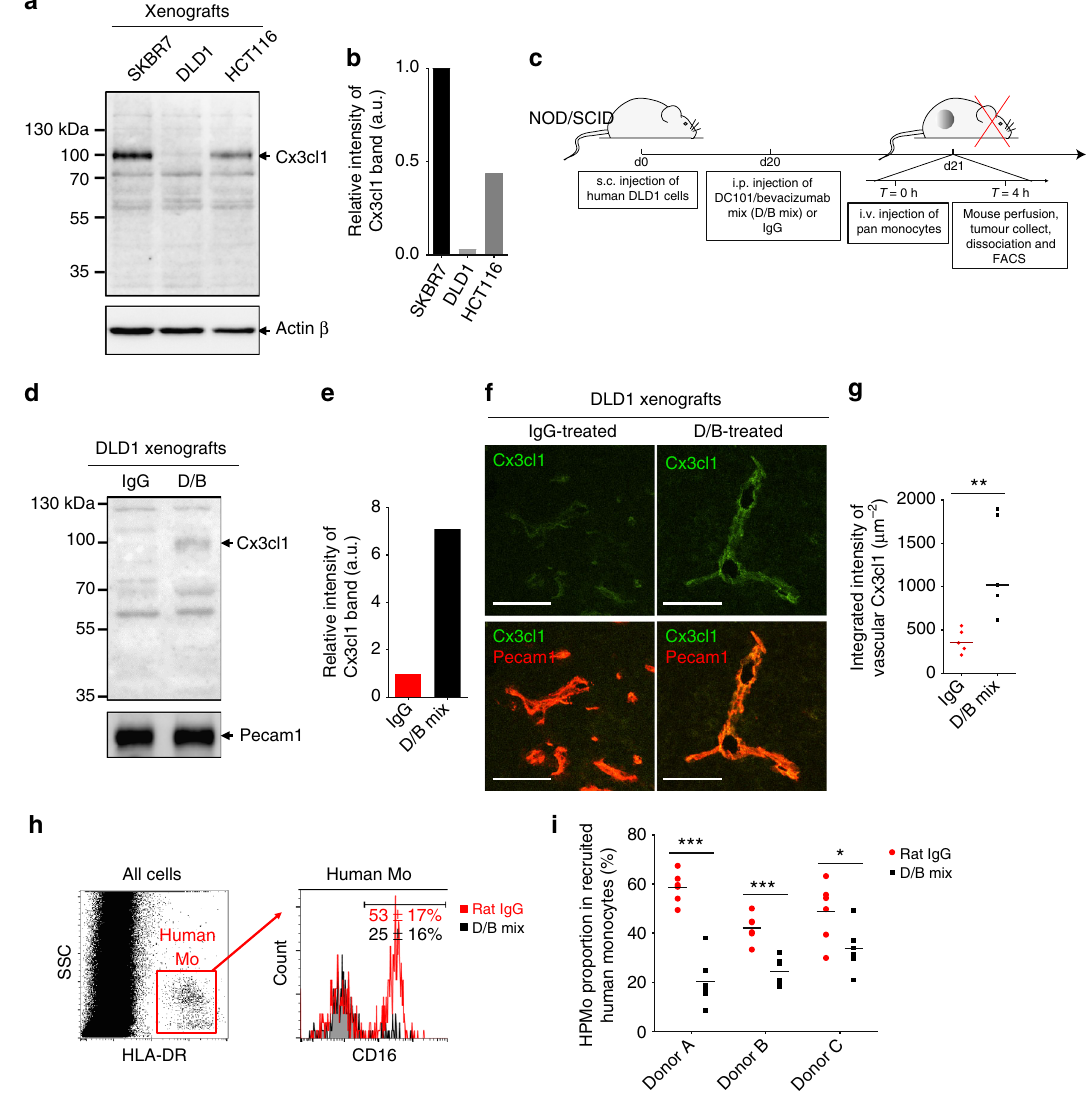
Fig. 7 Blocking VEGF-A signalling inhibits homing of proangiogenic monocytes to tumours. a Analysis of Cx3cl1 protein expression in xenografts of SKBR7, DLD1 and HCT116 tumours. b Quanti fi cation of Cx3cl1 band intensity in a after normalisation with same sample Actin level. c Scheme of the study of VEGF- A implication in human monocyte recruitment in DLD1 xenograft. DLD1 xenograft-bearing mice were treated either with the mixture of DC101 and bevacizumab (D/B mix) or control IgG for 24 h before adoptive transfer of human pan monocytes. The mice were perfused with PBS-EDTA to wash out circulating and non-extravasated leucocytes before tumour collect and analysis. d Analysis of Cx3cl1 protein level in DLD1 tumour after 24 h of D/B mix treatment by western blotting. e Quanti fi cation of Cx3cl1 band intensity in d after normalisation with Pecam1 level in same samples. f Expression level of Cx3cl1 in tumour vasculature by immuno fl uorescence of DLD1 xenografts. Scale bar = 80 µ m. g Quanti fi cation of Cx3cl1 in blood vessels. Data are presented as scatter dot plots with medians. Each dot represent the mean intensity of Cx3cl1 per µ m 2 blood vessels from 10 sections of the same tumour. n = 5 tumours per group were used for this quanti fi cation. ** p < 0.005 in Mann – Whitney test. h FACS analysis of the effect of D/B mix on human proangiogenic monocyte recruitment to DLD1 xenograft. i Effect of blocking VEGF-A signalling on extravasation of proangiogenic monocytes from different donors. The data presented as aligned dot plot with medians. n = 6 tumours per group in independent adoptive transfer experiments with monocytes from three donors (DonorA, DonorB and DonorC). * p < 0.05, ** p < 0.005, *** p < 0.001 in multiple t